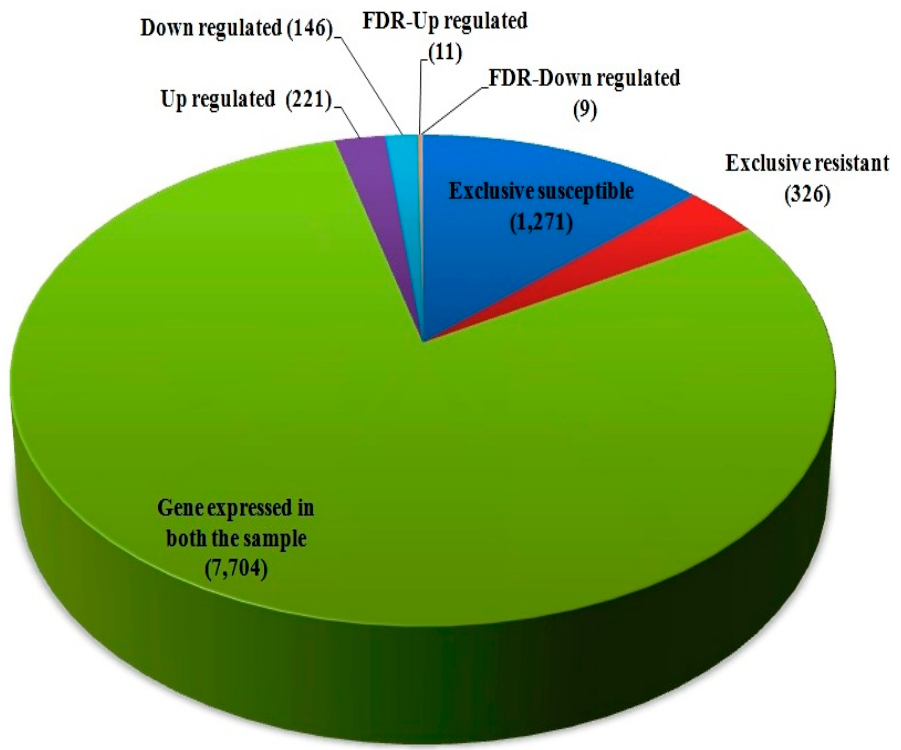
Figure 1. Differentially expressed genes (DEGs) between susceptible (WH542) and resistant (HD29) genotypes of wheat.